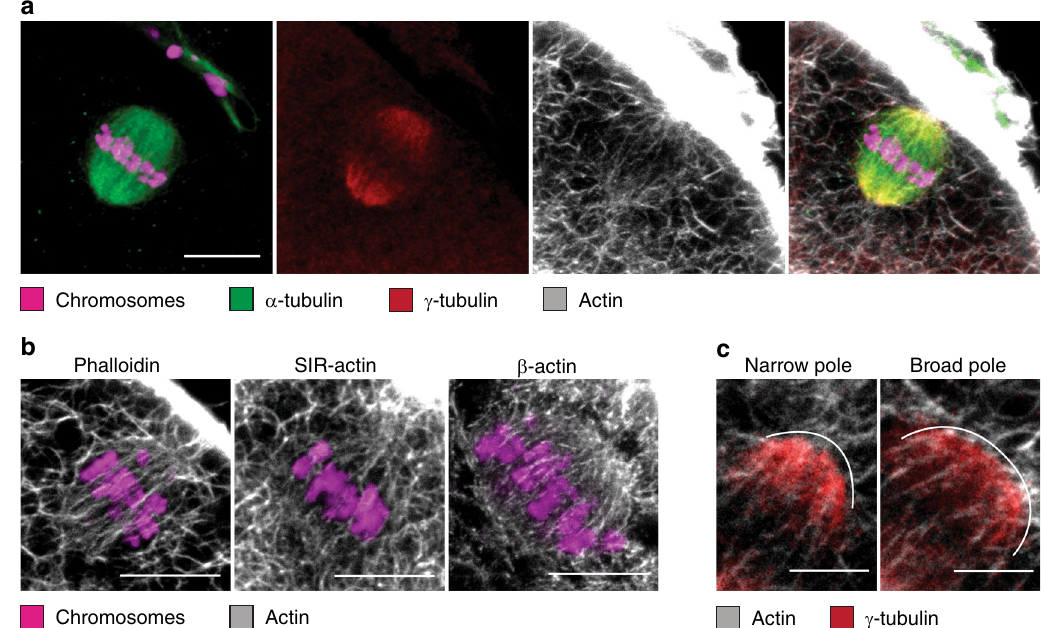
Fig. 1 Filamentous actin spans the entire microtubule spindle volume in human metaphase II oocytes. a Representative z -projection of a metaphase II oocyte. Microtubules ( α -tubulin), γ -tubulin, and actin (phalloidin) merge at the spindle poles; z = 6 sections. Representative of n = 5 oocytes. Scale bar, 10 μ m. b Immuno fl uorescence projections of MII human oocytes stained for chromosomes (Hoechst) and fi lamentous actin visualized with fl uorescent phalloidin, SiR-Actin, and anti- β -actin antibody; z = 6 sections. Representative of n = 14, 3, and 4 oocytes. Scale bars, 10 μ m. c Close-up view of actin (phalloidin) and γ -tubulin distributions at narrow and broad spindle poles of metaphase II oocytes; z = 6 and 8 sections. Representative of n = 12 oocytes. Scale bars, 5 μ